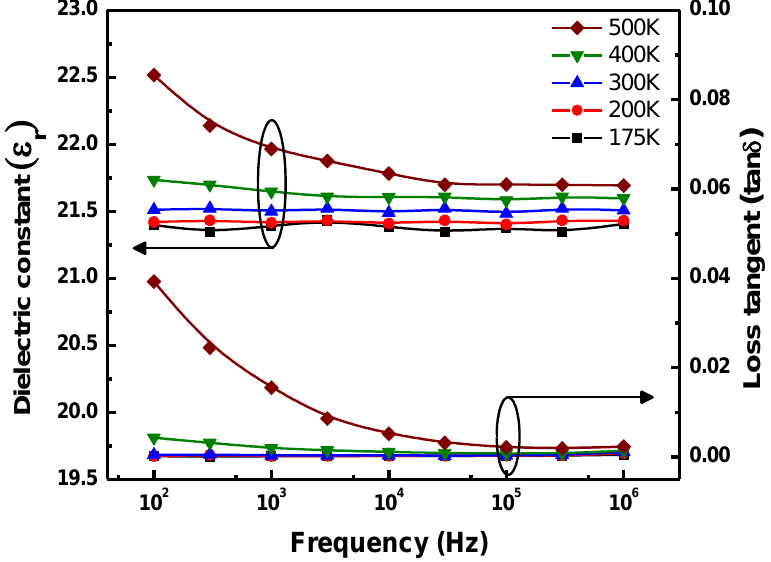
Figure 4. Variation in the dielectric constant and loss tangent of LaGdO function of frequency in the 175–500 K temperature range. Reprinted with permission from [15]. Copyright 2012 AIP Publishing